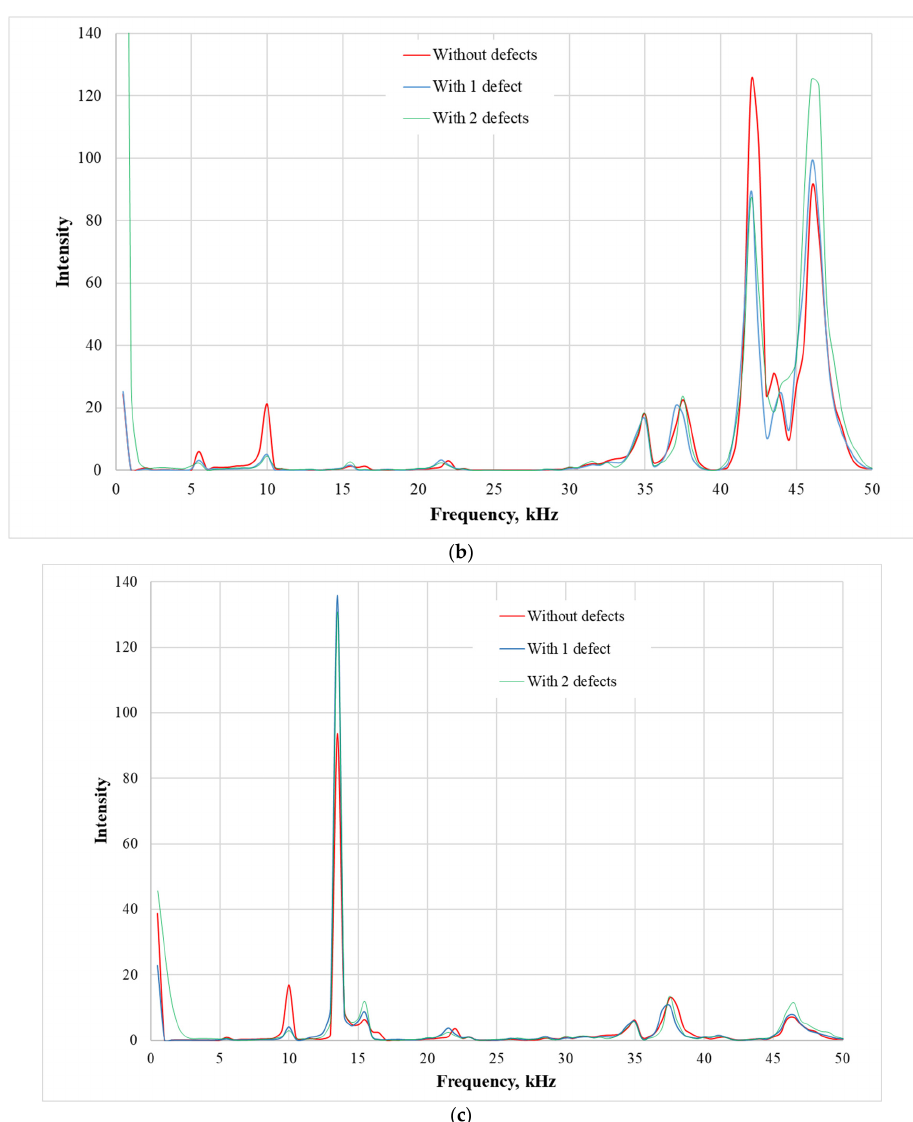
Figure 10. Spectrograms of the composite plate responses to the impact force for the impulse duration time of: ( a ) 9.5 × 10 − 5 s; ( b ) 7.7 × 10 − 5 s; and ( c ) 2.4 × 10 − 5 s, respectively. The spectrograms of the composite plate responses to the mechanical impact input show that the composite material plate without defect and the composite material plate with a defect give different forms of the signals according to the frequency and amplitude of the resonances. These differences in the signals are essential to the identification of the defect in the composite plate. The excitation frequency higher than 50 kHz is not informa- tive at all due to environmental noise. Therefore, the spectrograms are analyzed in the frequency range from 1 Hz to 50 kHz. The highest response amplitudes are observed at